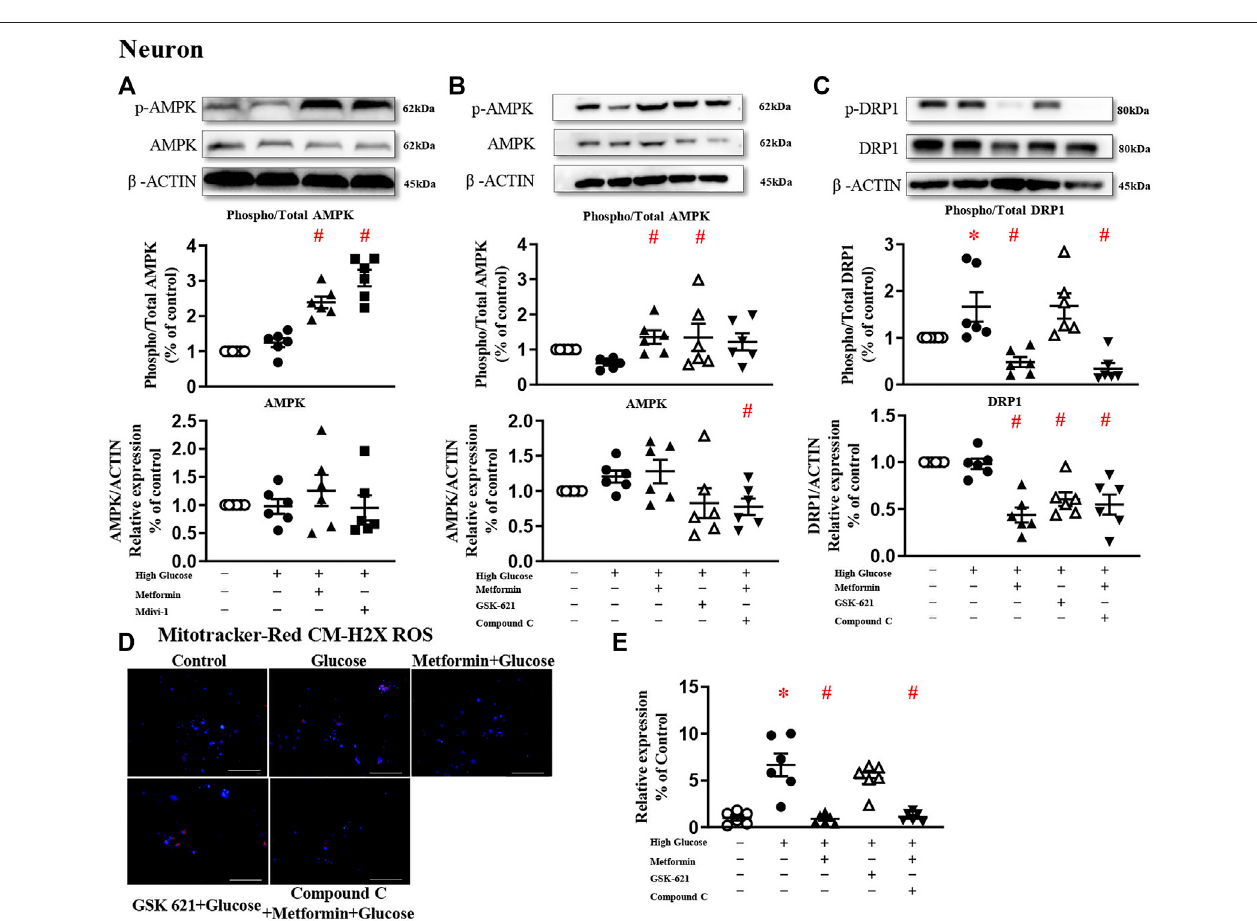
FIGURE 5 | The protective effect of metformin is attributed to DRP1 phosphorylation but not AMPK activation in primary neurons. (A) Representative blots and densitometric quanti fi cation of AMPK protein in primary neurons. The phosphorylation of AMPK (top blots) was normalized to total AMPK protein (middle), and total AMPKwasnormalizedto β -ACTIN(bottom). (B) Representativeblotsanddensitometricquanti fi cationofAMPKproteininprimaryneuronsstimulatedhighglucoseinthe presenceofGSK621orCompoundC.ThephosphorylationofAMPK(topblots)wasnormalizedtototalAMPKprotein(middle),andtotalAMPKwasnormalizedto β -ACTIN(bottom). (C) Representativeblots,anddensitometricquanti fi cationofDRP1proteininprimaryneuronsstimulatedhighglucoseinthepresenceofGSK621,or CompoundC.ThephosphorylationofDRP1(topblots)wasnormalizedtototalDRP1protein(middle),andtotalDRP1wasnormalizedto β -ACTIN(bottom).Fluorescent